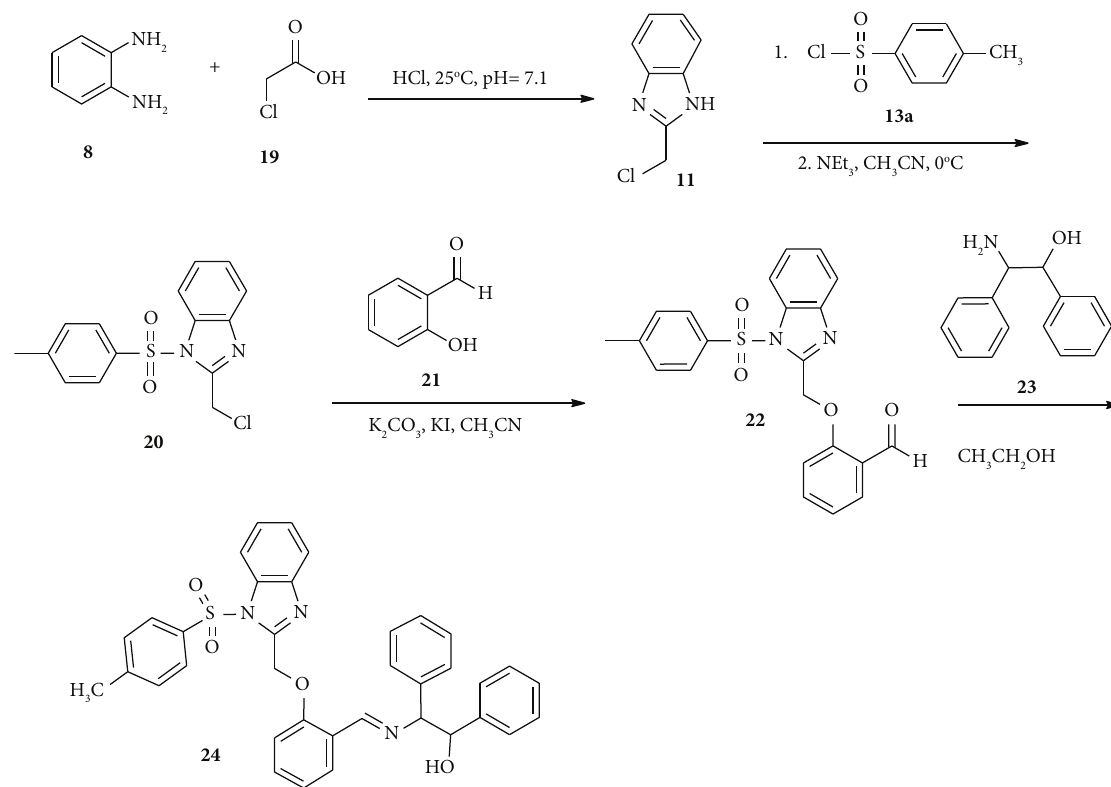
Scheme 3: Synthetic routes towards compound